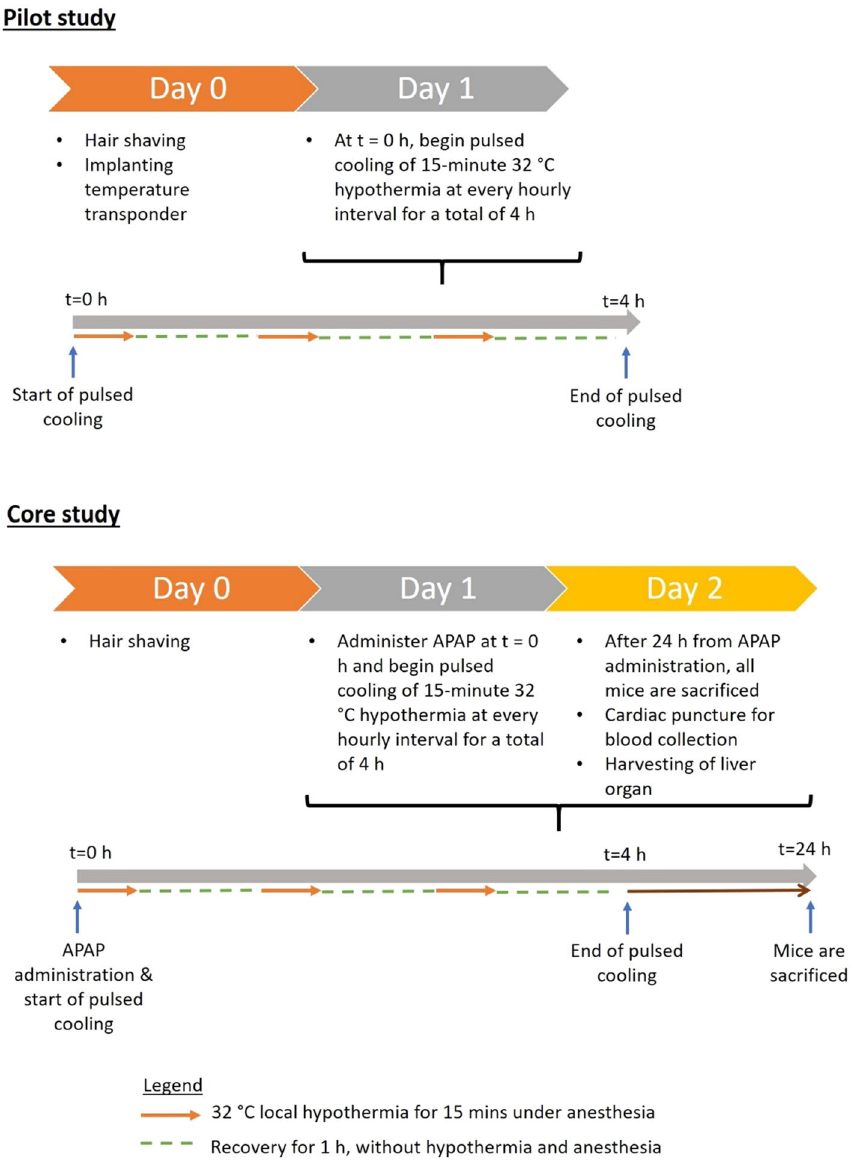
Figure 2. A summary of the in vivo experimental set-up for pilot and core study.